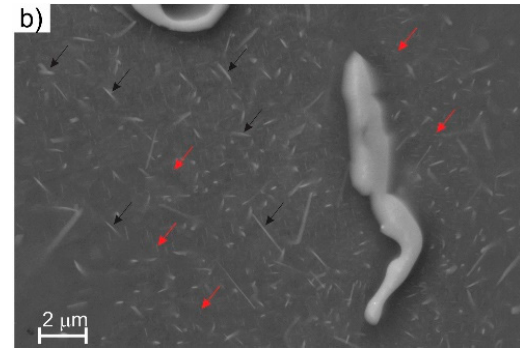
Figure 4. SEM micrographs of microstructural constituents of the sample in as-cast state ( a ) and after 4 ( b ), 5 ( c ), 6 ( d ), and 12 ( e ) h of homogenisation at 520 °C, with the corresponding EDS results shown in at. %.